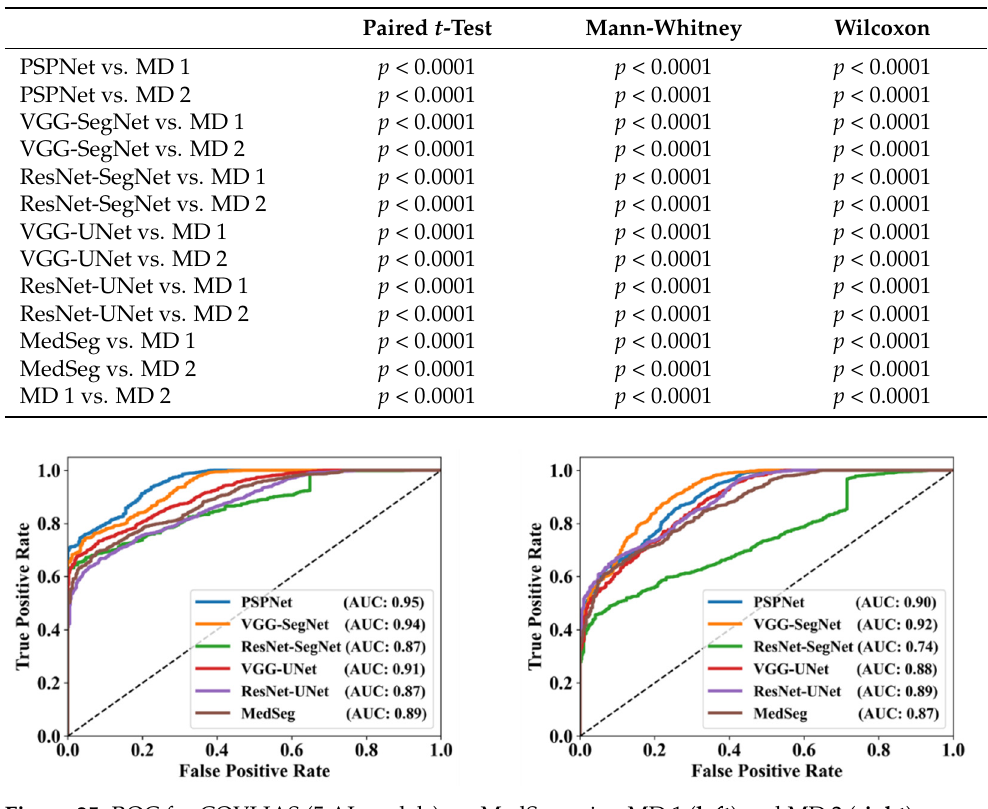
Figure 25. ROC for COVLIAS (5 AI models) vs. MedSeg using MD 1 ( left ) and MD 2 ( right ).